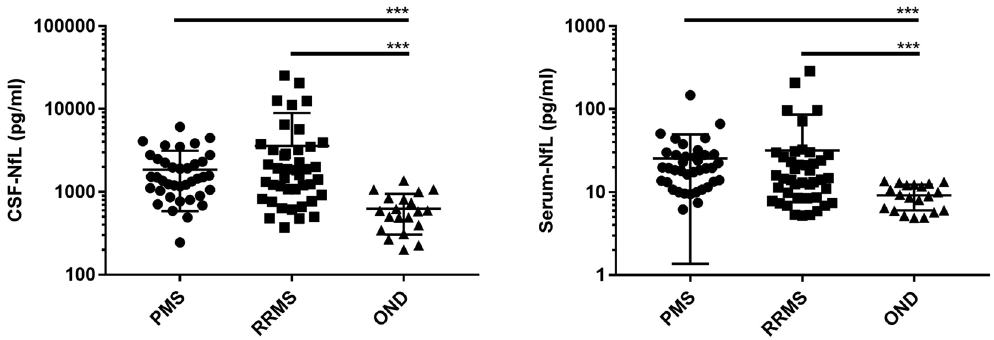
Figure 3. NfL CSF and serum levels in multiple sclerosis patients and patients with other non-inflammatory neurological diseases (OND). NfL: neurofilament light chain, CSF: cerebrospinal fluid, PMS: progressive multiple sclerosis, RRMS: relapsing-remitting multiple sclerosis. OND: other non-inflammatory neurological diseases. P-values were calculated with Kruskal-Wallis test followed by Dunn ’ s multiple comparison test. *** p <